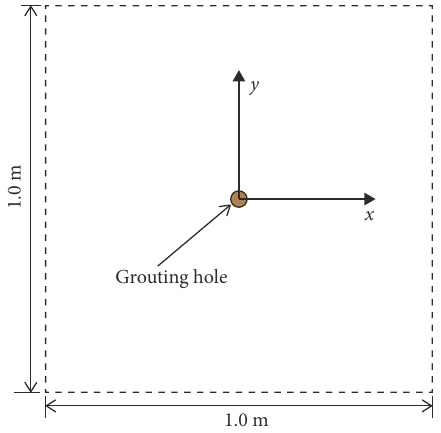
Figure 3: Geometric sizes of the fracture in Case 1.